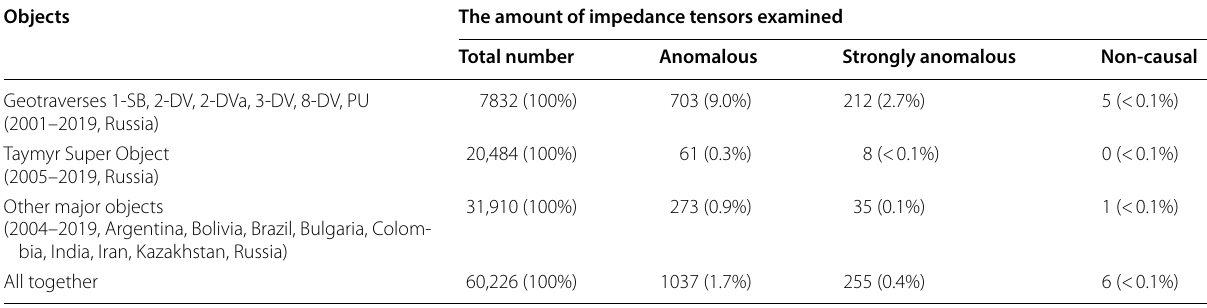
Table 2 The DR violation statistics for the impedance tensors from the onshore MT/BBMT database of Nord-West Ltd